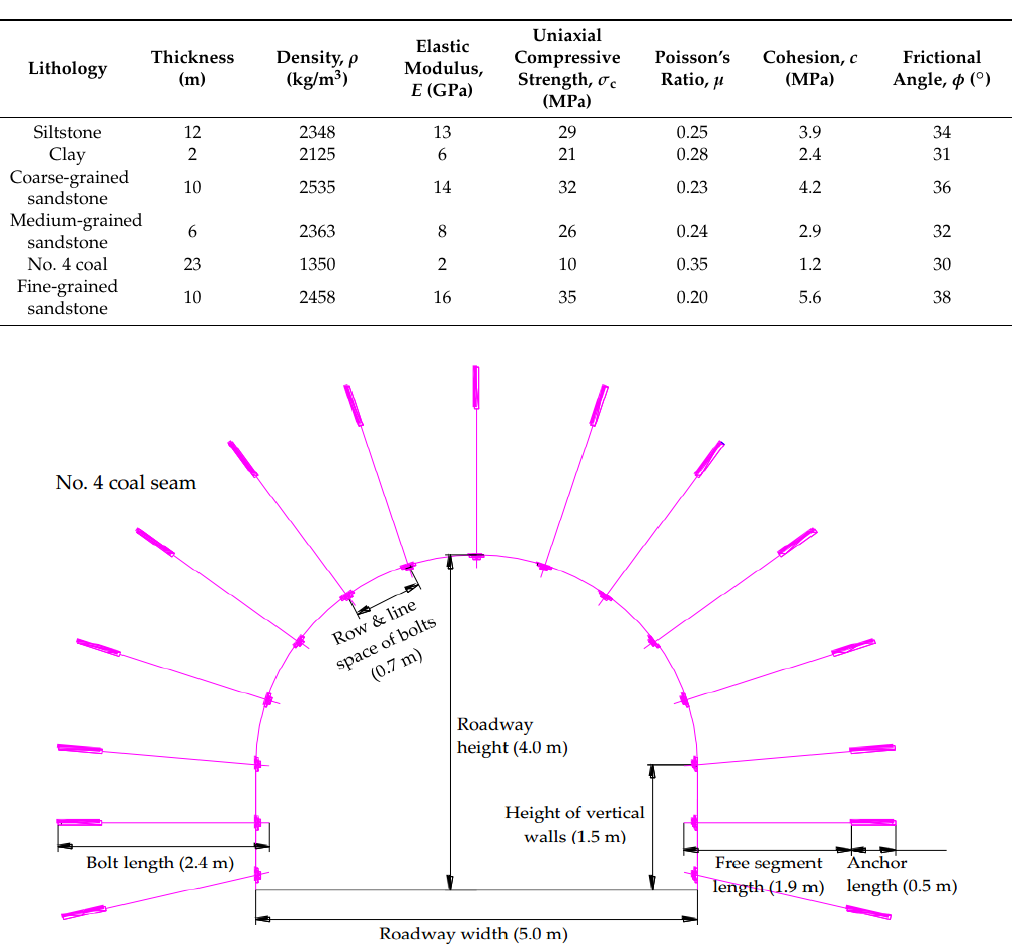
Figure 8. Track roadway’s supporting parameters, including bolt length, anchor length and row and line space of bolts. line space of